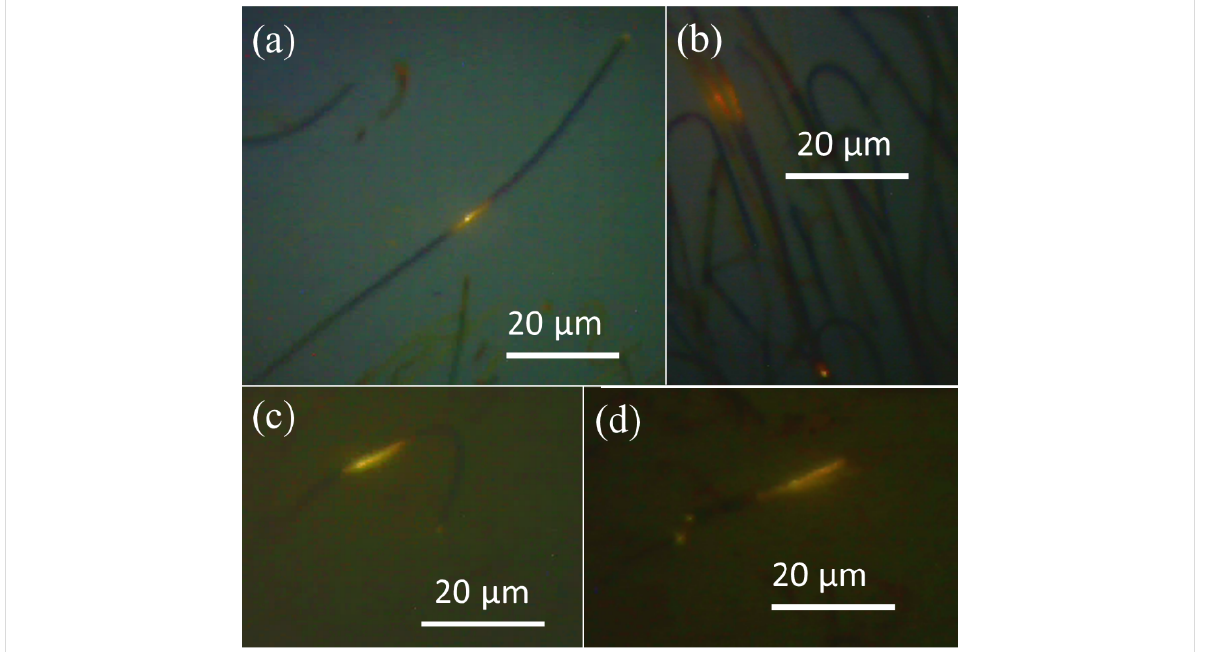
Figure 7: Waveguide nature of (a), (b) square-shaped NWs and (c), (d) cylindrical-shaped NWs.